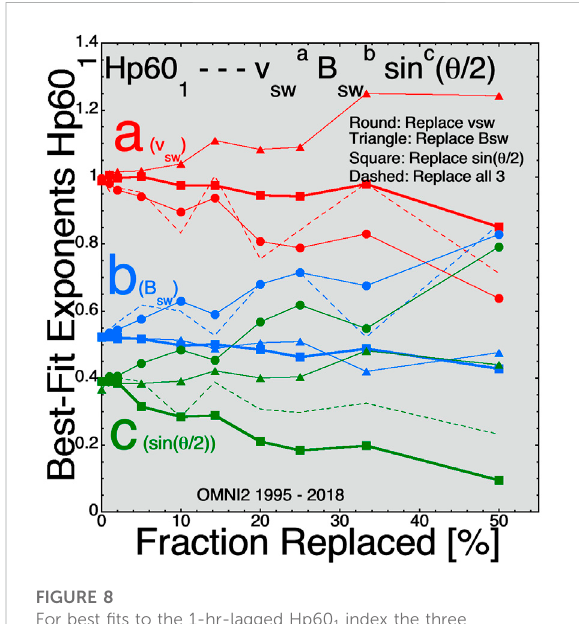
FIGURE 8 For best fi ts to the 1-hr-lagged Hp60 1 index the three exponents (A) (red), (B) (blue), and (C) (green) are plotted as functions of the fraction of time-series values replaced for three solar-wind variables.